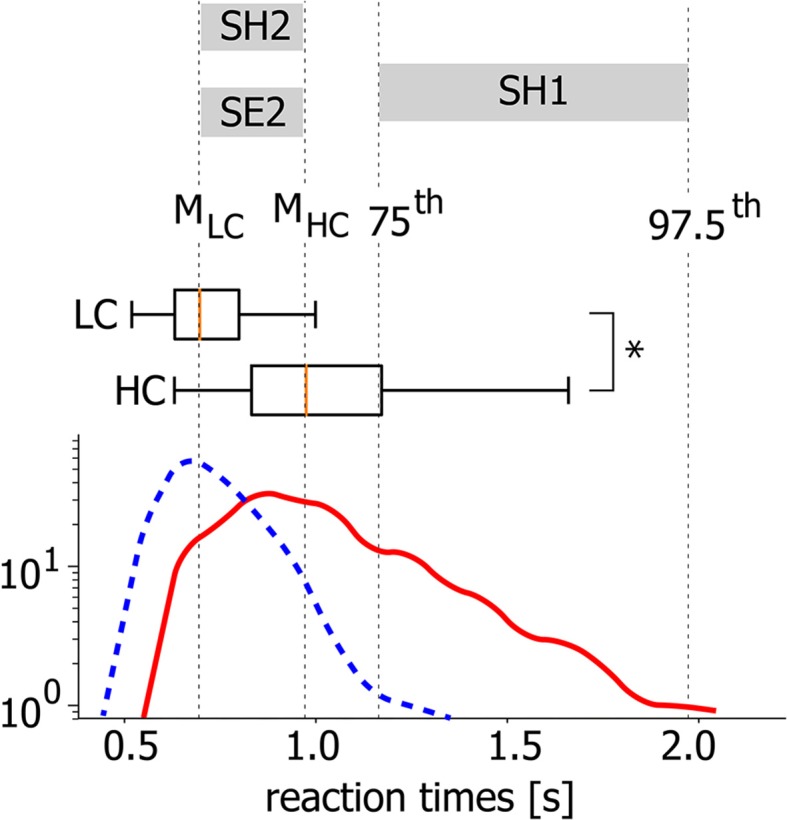
Different task conditions. Typical probability distribution functions (PDFs) of RT for HC (solid line) and LC (dashed line) tasks and corresponding box-and-whisker diagrams for a single subject (*p < 0.05 via Mann-Whitney U-test for 200 stimuli). MLC and MHC correspond to medians of the PDFs.